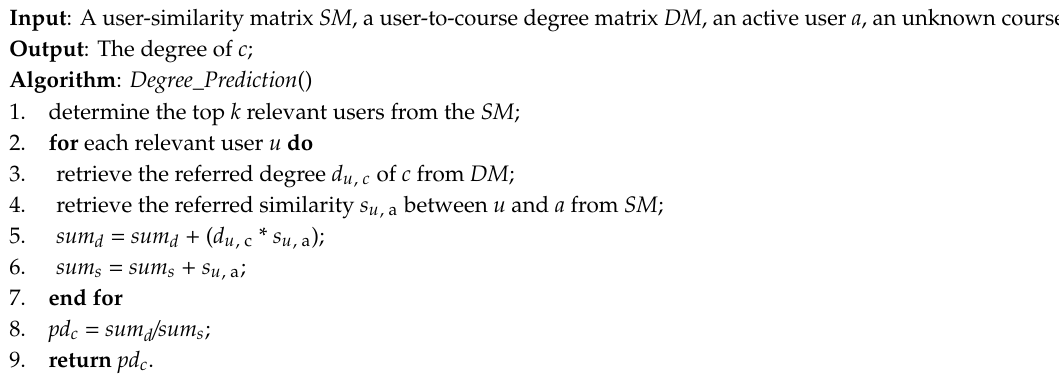
Algorithm 2. Course degree prediction.